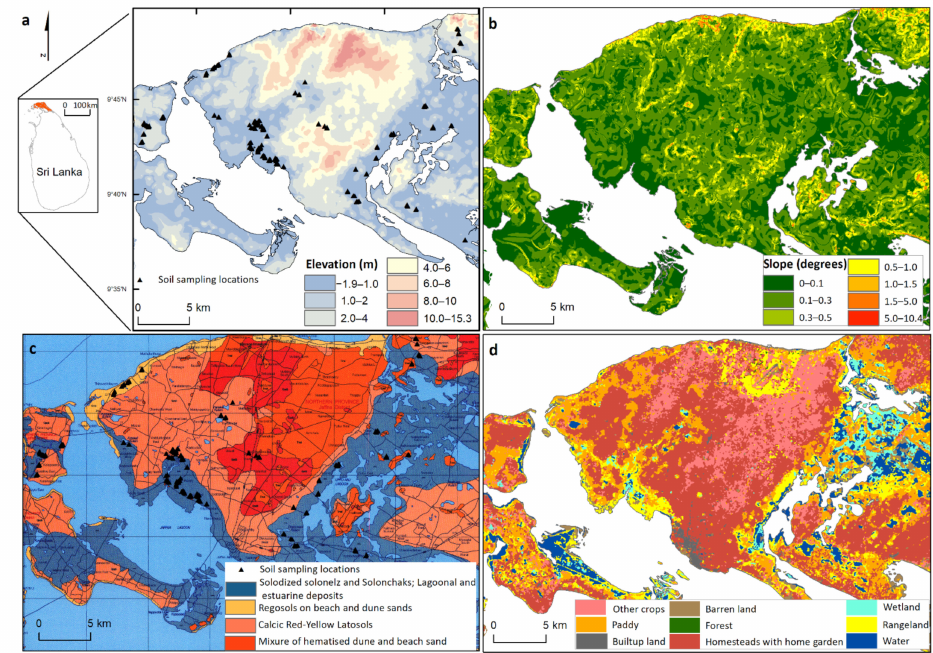
Figure 2. ( a ) Location of study area and spatial distribution of soil samples overlaid on digital elevation model (DEM); ( b ) slope map; ( c ) soil map; ( d ) land-use map of the study